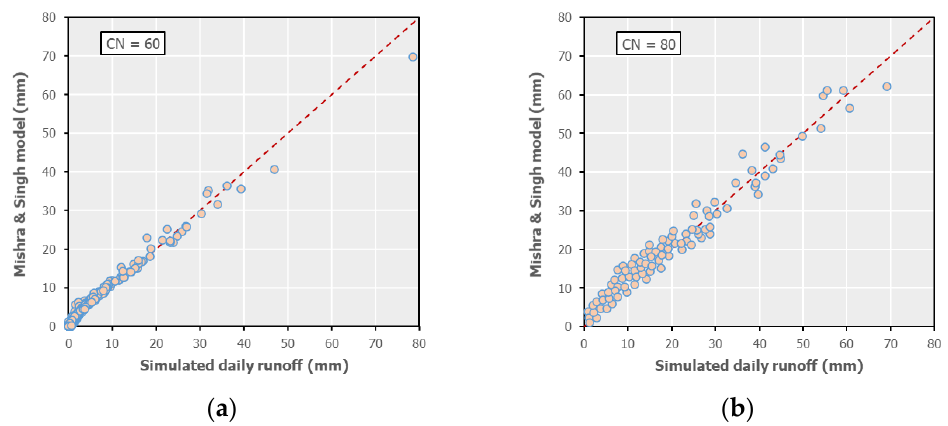
Figure 7. Scatter plots of daily runoff estimated through the proposed approach vs. the continuous simulation scheme by Mishra and Singh [38] for reference values ( a ) CN II = 60 , and ( b ) CN II = 80.